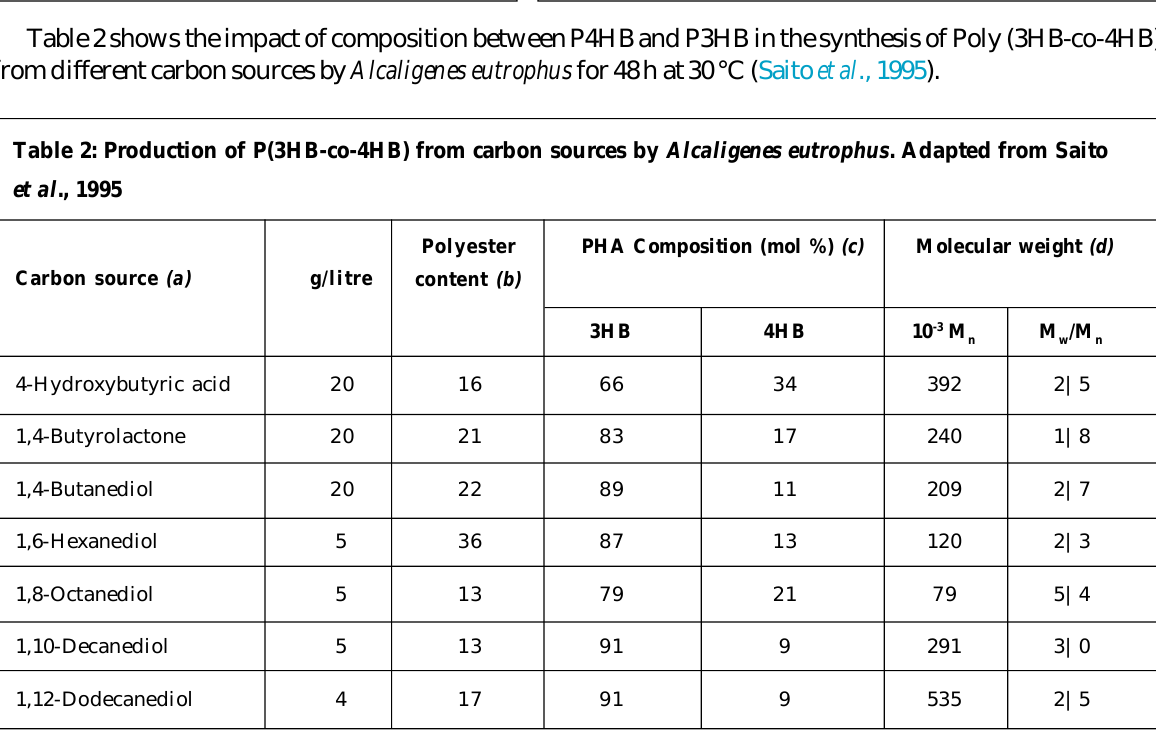
Figure 3: PHB granules in the chloroplast of Arabidopsis thaliana, Retrieved from Lenz and Marchessault, 2004